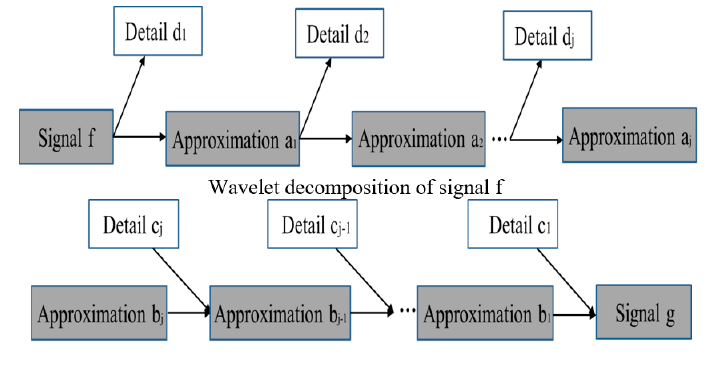
Figure 1. Signal reconstruction and decomposition process.